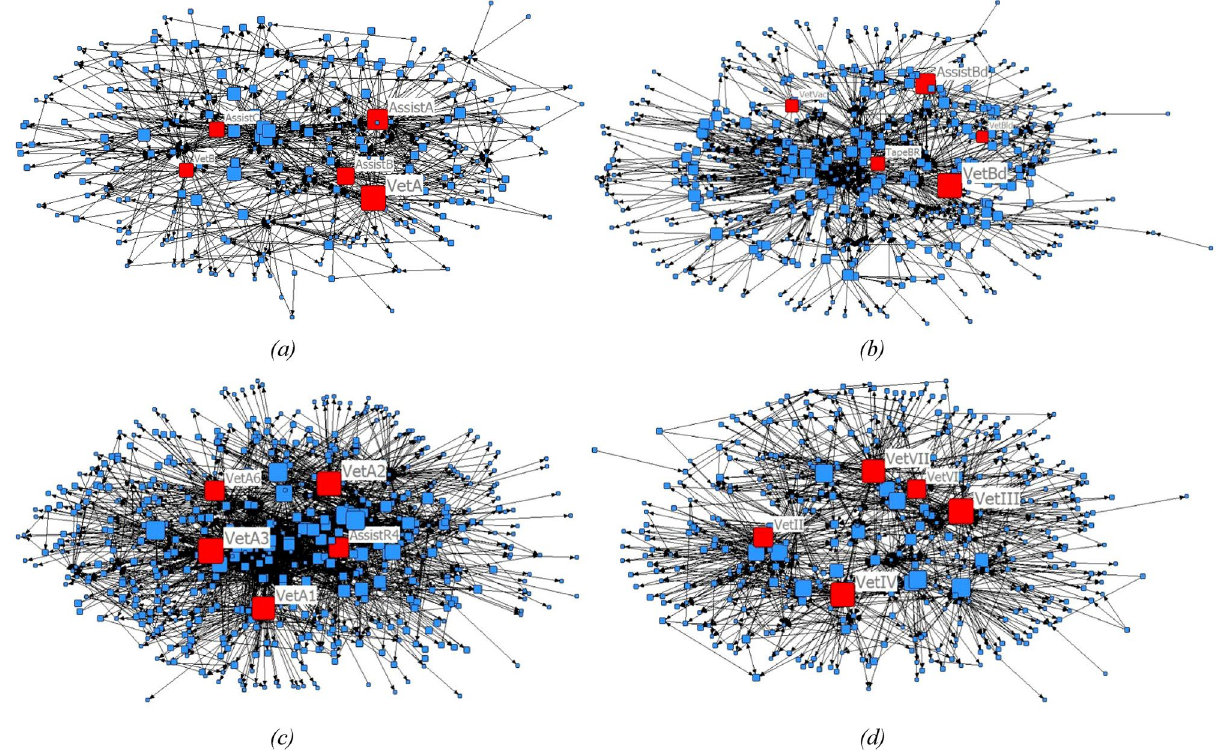
Figure 1. Sociogram of contact networks categorised by department. Each square symbol represents an individual node. The node size varies based on its key player determination value. The red square node represents the five nodes with the highest key player determination values. (a) Critical care unit; (b) outpatient department; (c) operation room; (d) ward. The figure was generated in NetDraw 2.160 (https ://sites .googl e.com/ site/netdr awsoft ware